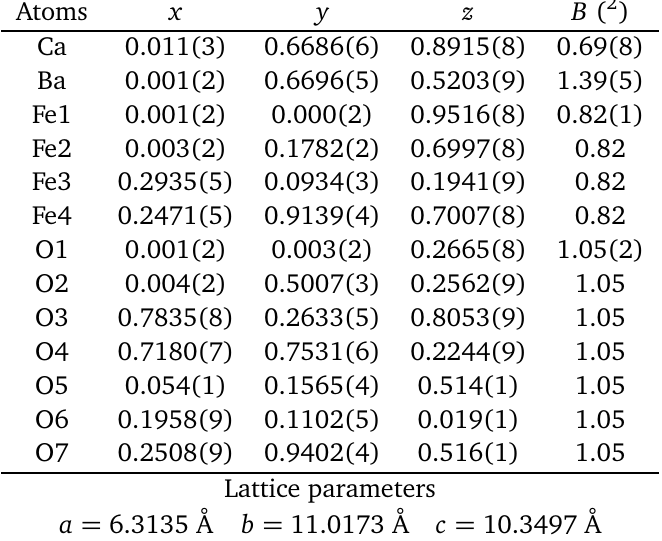
Table 1: Refined nuclear structure parameters within the P bn 2 = 4.7, R = 2.9, χ 2 = 4.3). The only Wyckoff site in this space group is the ( R F,1 F,2 general 4 a site. Note that not all atomic positions can be refined at the same time due to the absence of a special position, i.e. the origin needs to be fixed. The extinction parameters x are the diagonal entries of a tensor used to calculate the extinction ii factor. Note that the isotropic temperature factor B has been constrained to be the same for elements on different sites.